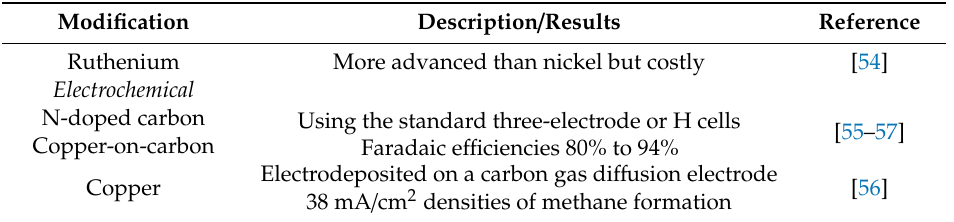
Table 1. Improvement of catalysts in methane production.